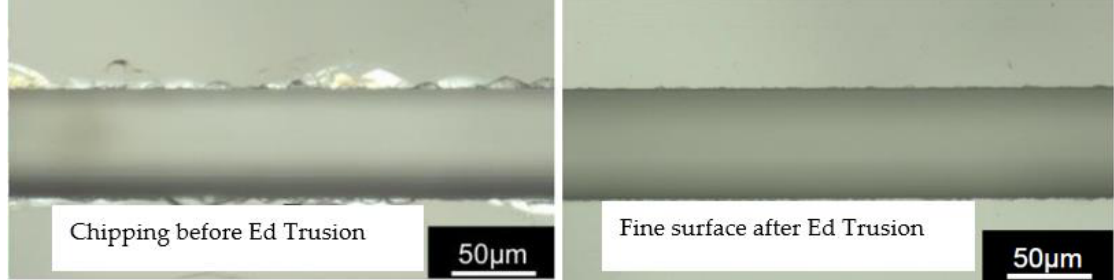
Figure 5. Groove cut with thin PCD blade before and after trusion [27].